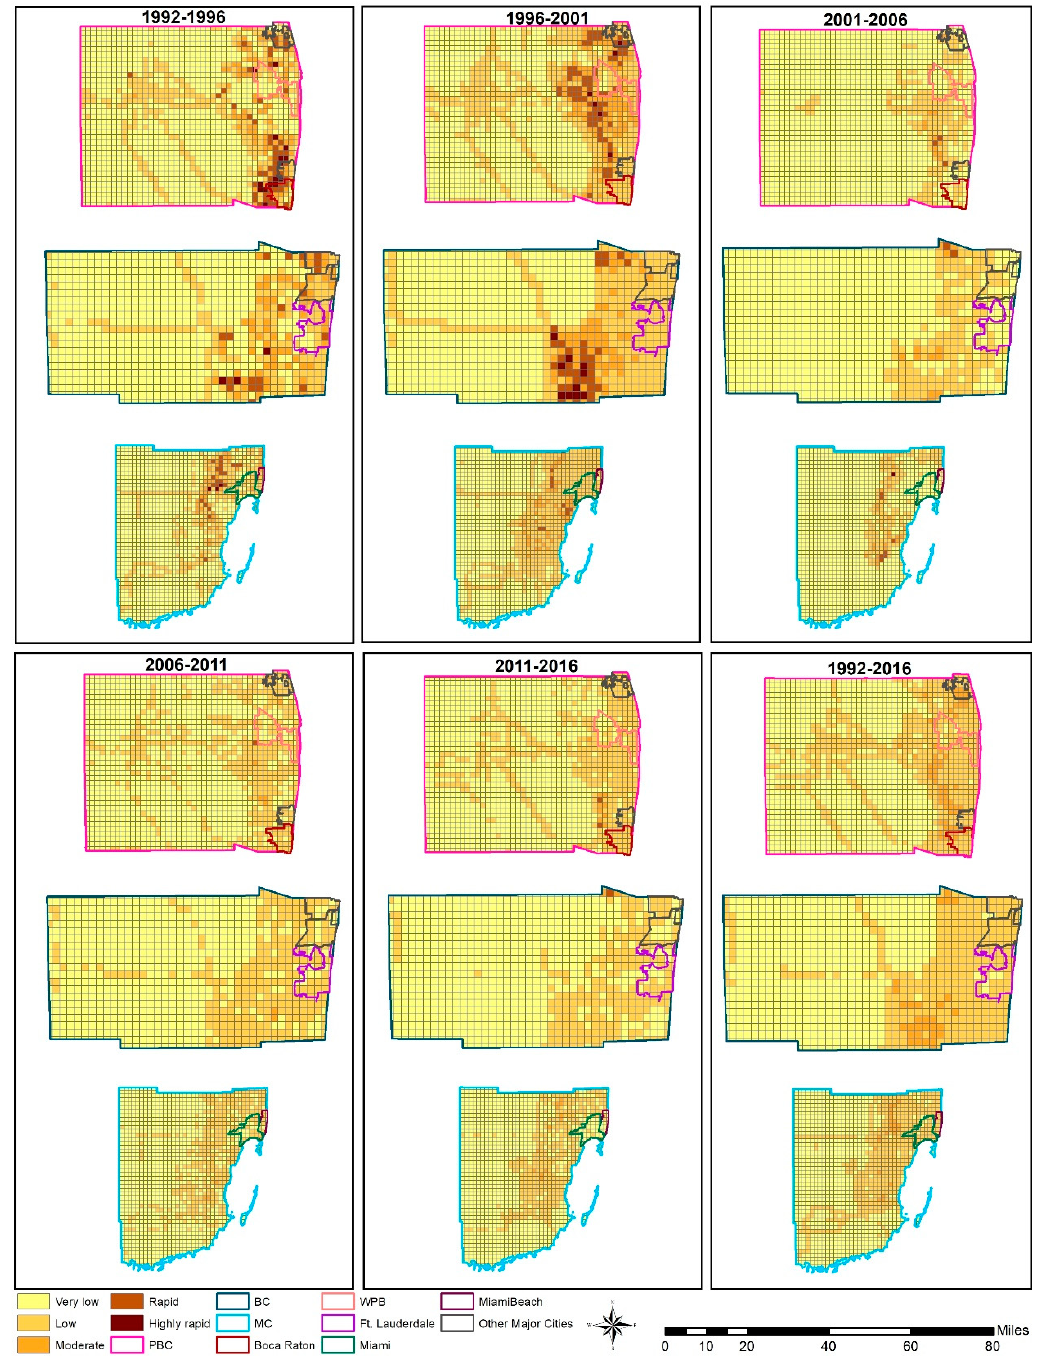
Figure 6. Spatial distribution of UII at County and City level at 2 km × 2 km spatial unit.